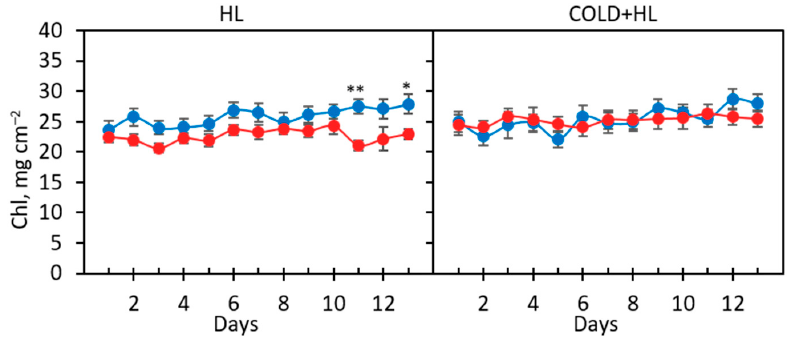
Figure 3. Chlorophyll content in the GL adaxial epidermis of P. zonale plants during a five-day pretreatment (LL) and an eight-day exposure to low light (LL, 180 µmol m –2 s –1 , blue line) and to high light (HL, 800 µmol m –2 s –1 , red line) in the two experiments HL (25 °C; left) and Cold + HL (18 °C; right). Values represent means ± SE ( HL : n = 10; Cold + HL : n = 22). Significant differences between plants treated with LL and HL, according to the t -test in each experiment are indicated (* p < 0.05, ** p < 0.005).